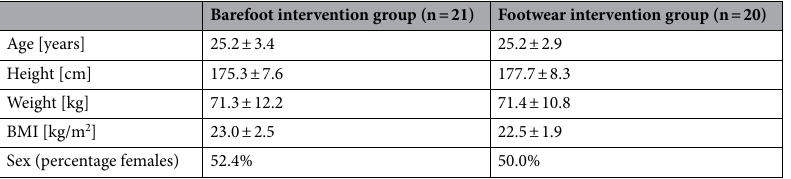
Table 1. Mean ± standard deviation of participant